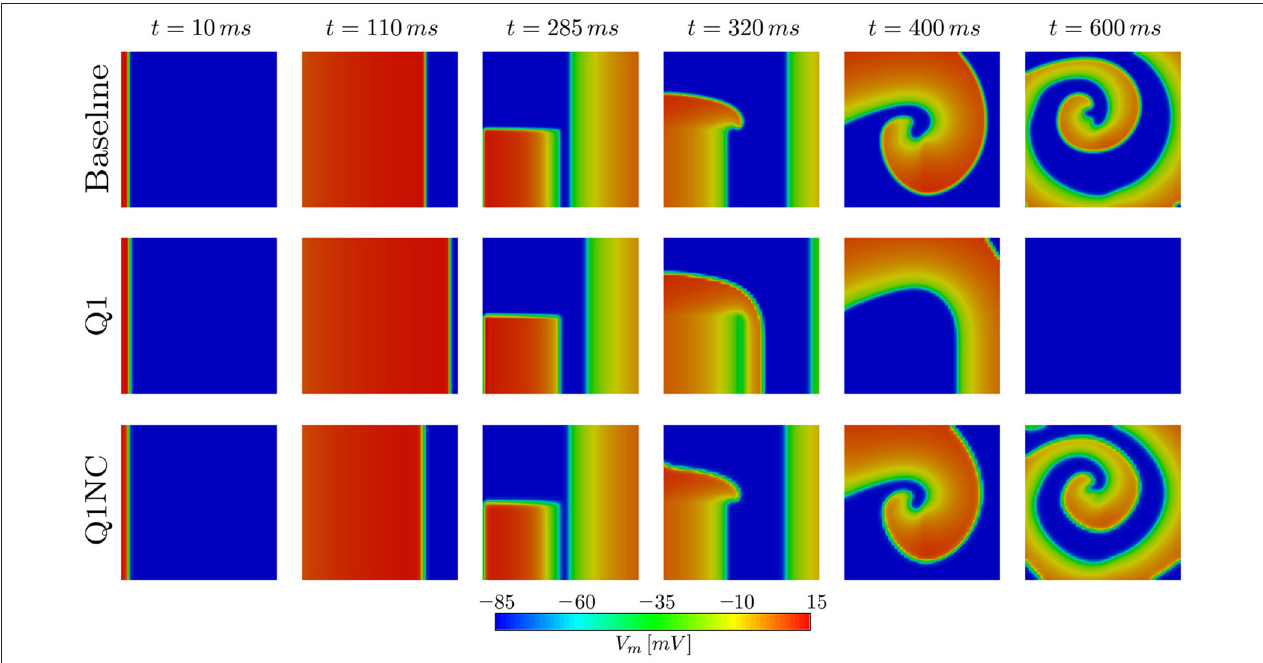
FIGURE 5 | Spiral generation simulation in a 2D slab. Due to the higher CV, the Q1 case (coarse mesh) cannot capture the genesis of the spiral